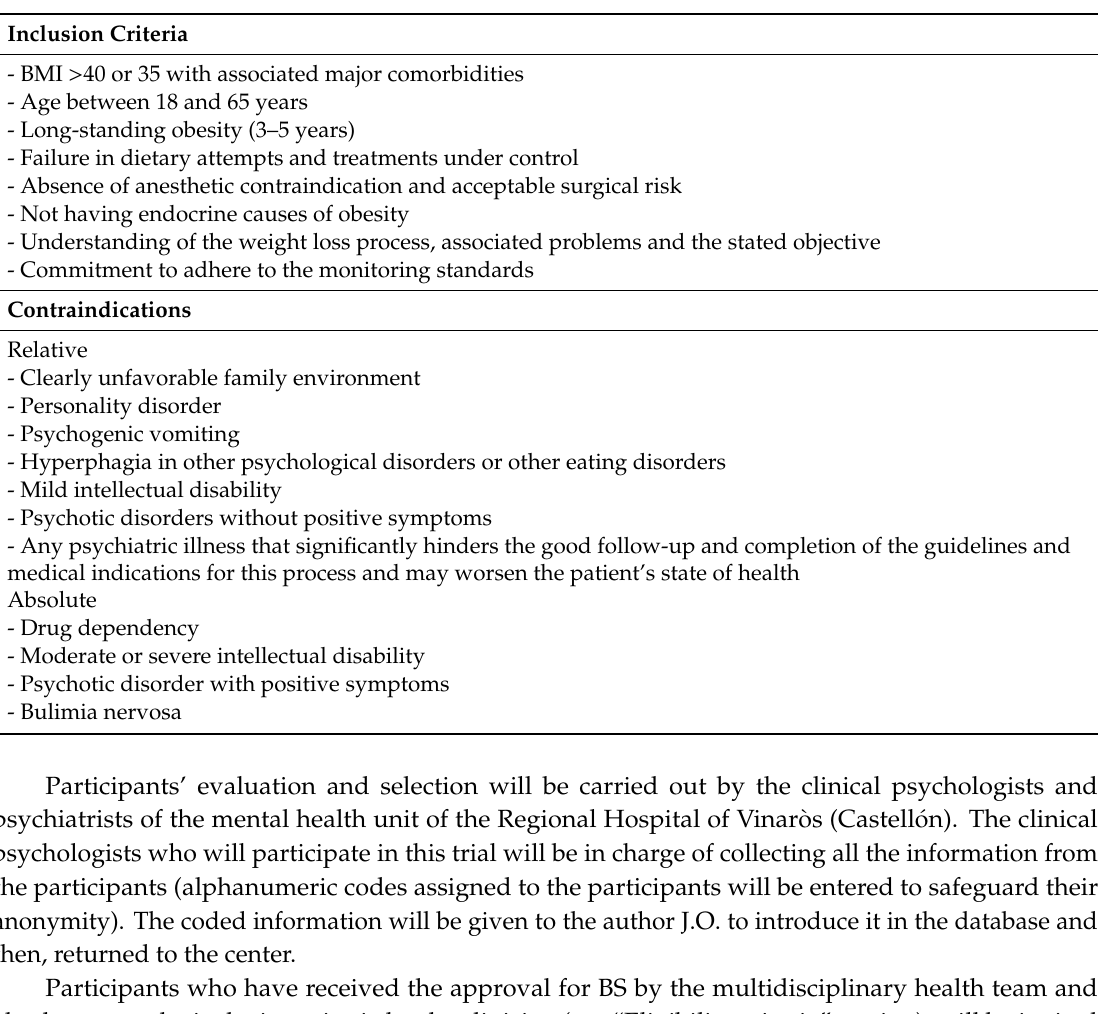
Table 1. Inclusion criteria and main contraindications for